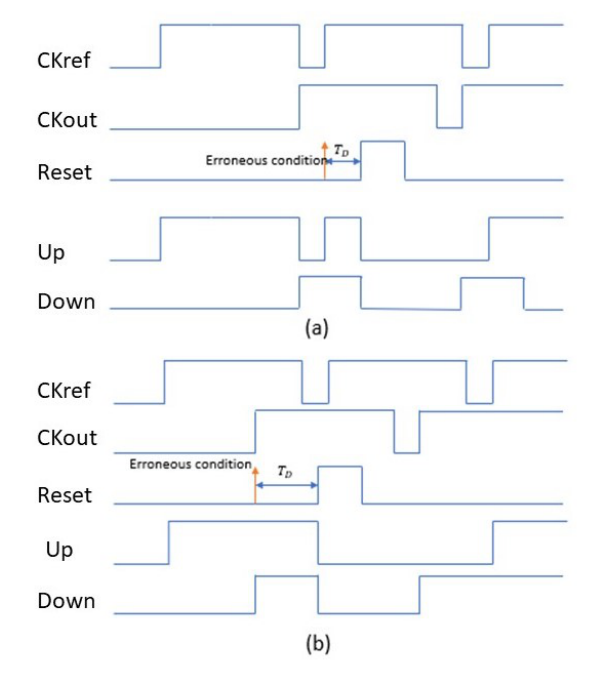
Figure 1. ( a ) Error caused by the RESET’s delay. ( b ) Error caused when RESET was delayed. The PFD cannot identify the phase difference, which is less than φ dz . Within this range, the phase at the PLL output tends to vary freely, leading to increased phase noise. The easiest solution to the dead-zone issue is by placing a fixed-delay element in the reset path of the PFD. This forces up pulses and down pulses to be active at the same time for a fixed period in every cycle whenever the PLL is locked. The disadvantage of the above technique is an imbalance in pulse-arrival times (as shown in Figure 2), and the up and down currents in the CP cause a periodic disruption of the control voltage of the VCO, resulting in reference spurs in the PLL output spectrum. Thus, the variable-delay element resolves this drawback since there is no fixed delay period and noW calls for a novel PFD.